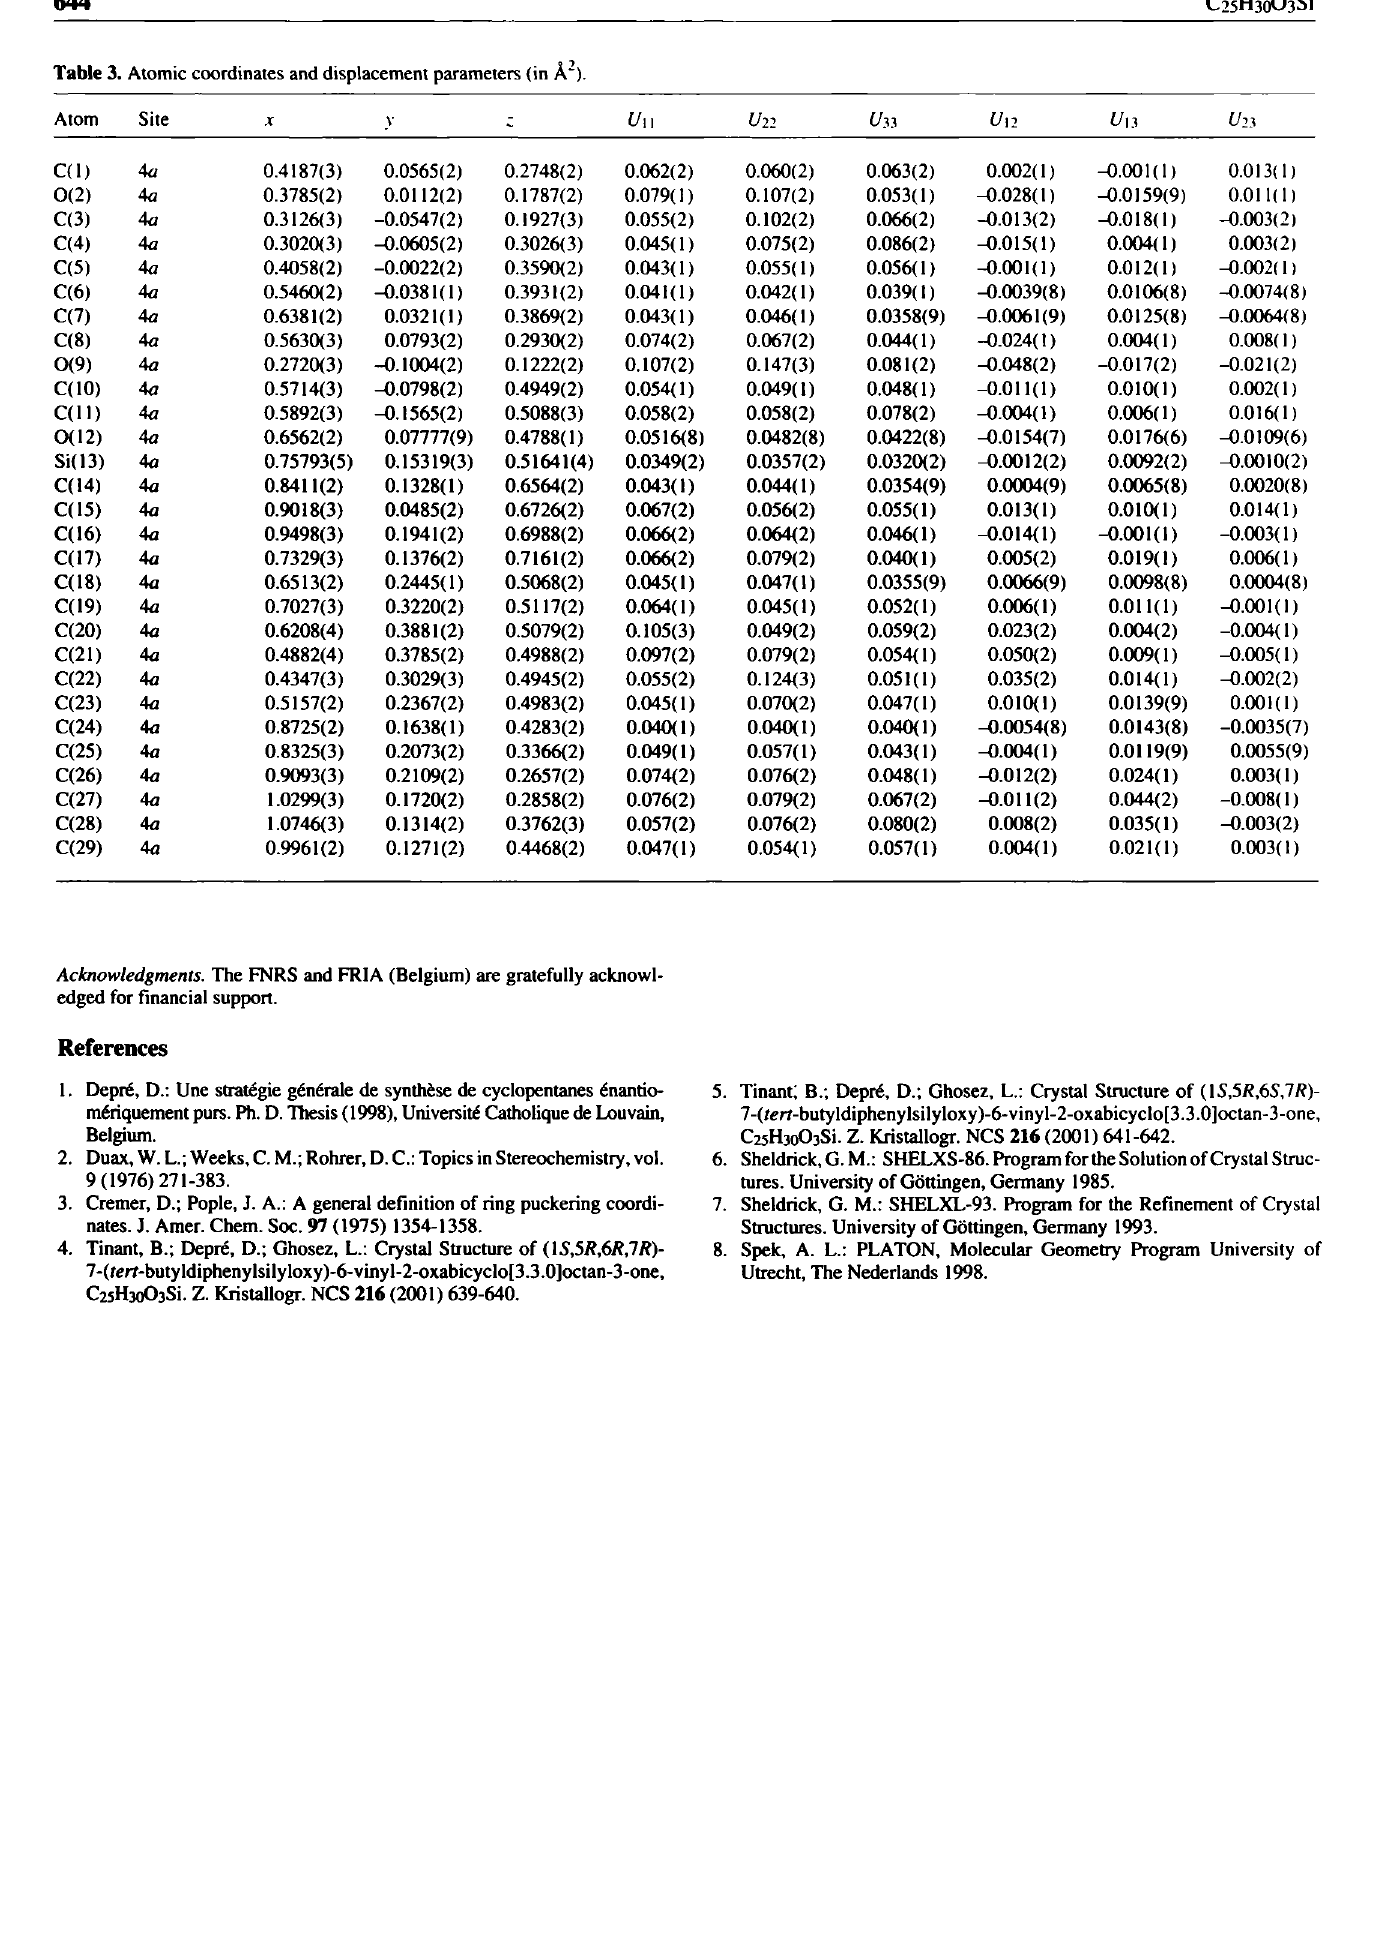
Table 3. Atomic coordinates and displacement parameters (in Ä 2